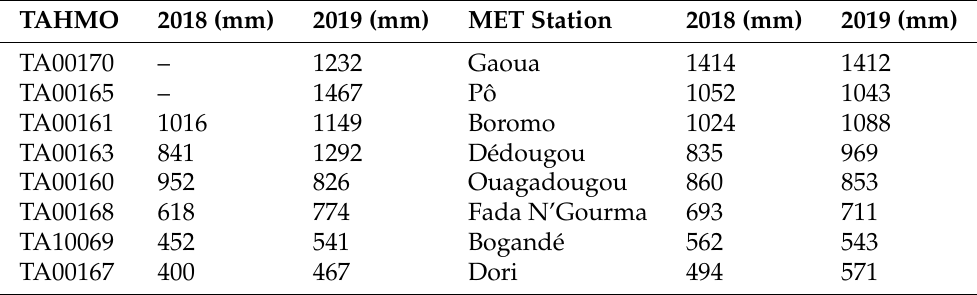
Table 2. Annual cumulative precipitation sum (mm) from 2018 and 2019. The amount of precipitation decreases towards the north. “–” shows that missing values (MVs) are present and can therefore not be included in the comparison. Because of the high number MVs in both years, TA00162 was completely neglected. Station TA00164 is also not involved due to the higher number of outliers within precipitation time